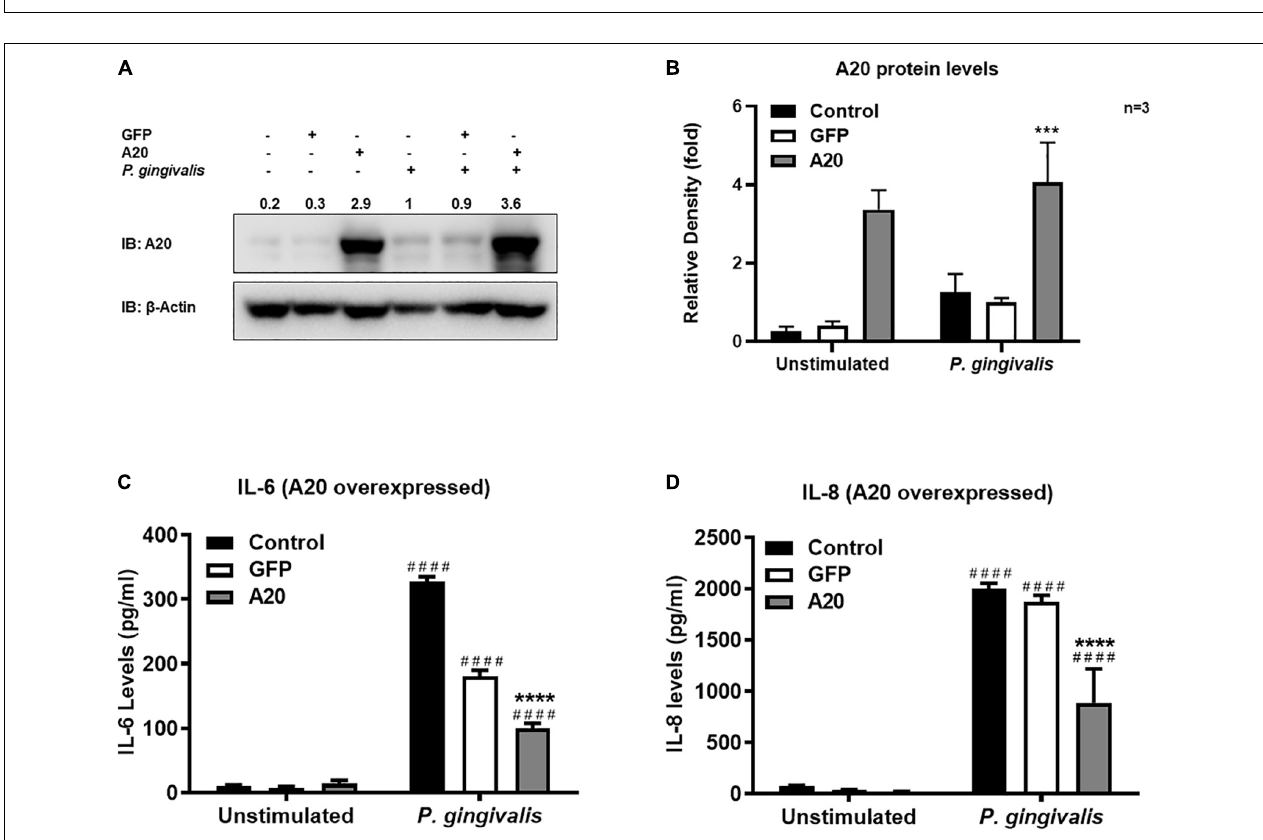
FIGURE 3 | Exogenous expression of A20 inhibits inflammatory cytokine production in human gingival keratinocytes. ELISA cytokine production assays of TIGKs with exogenous A20 expression or control cells infected with P. gingivalis . TIGKs were infected with lentivirus expressing A20 or GFP and infected with killed P. gingivalis (100 MOI) for 6 h. Cells were lyzed for indicated protein levels, represent Western blots were shown (A) . Relative protein levels for three independent experiments were plotted with mean ± SD (B) . IL-6 (C) and IL-8 (D) levels in the supernatants were determined with ELISA. Each experiment was performed three times independently and representative experiments were shown. Bar graphs: Values are presented as mean and standard error. #### Unstimulated cells versus corresponding P. gingivalis infected cells ( P ≤ 0.0001); **** P. gingivalis infected A20 depleted cells compared to infected controls ( P ≤ 0.0001); *** P. gingivalis infected A20 depleted cells compared to infected controls ( P ≤